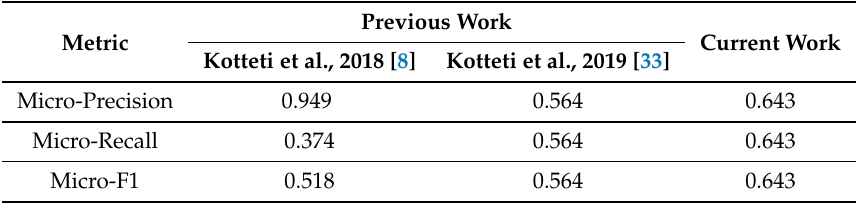
Table 4. Comparison of current work to our previous